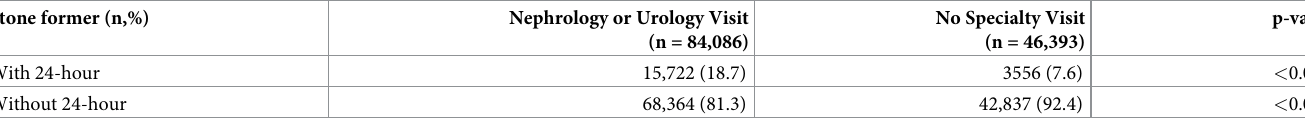
Table 3. Stone specialty (Nephrology or Urology) provider care 6 months after stone diagnosis. Stone former